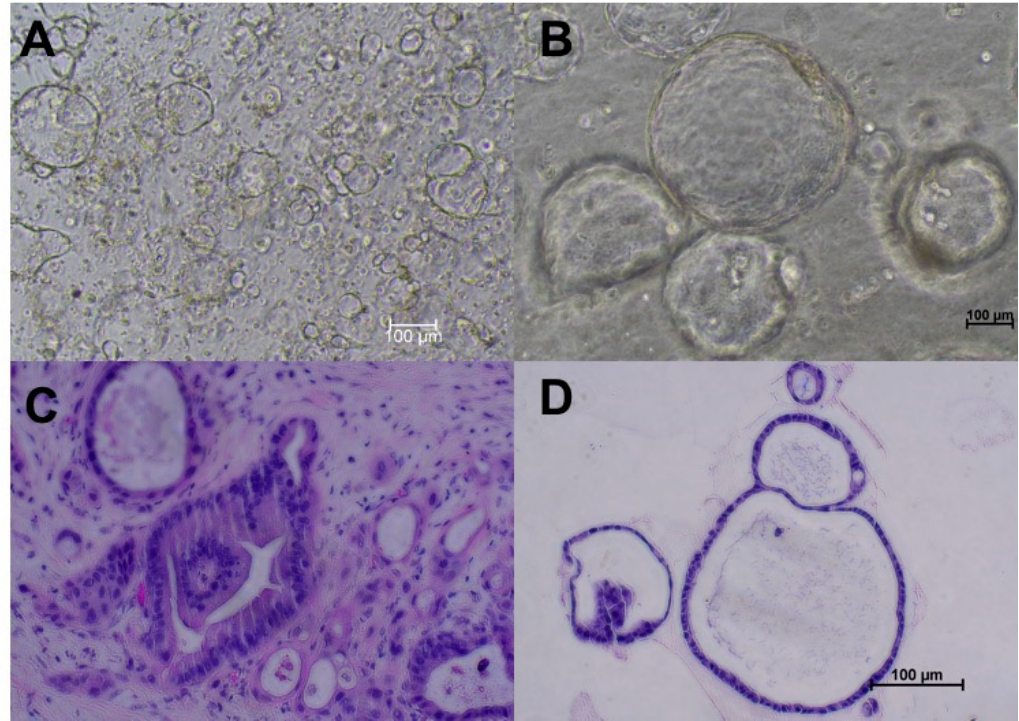
Figure 1. Pancreatic duct adenocarcinoma (PDAC) organoids created from specimens obtained from surgical resection from the same patient. ( A ) Passage 0 (P0) organoids on day 4 after creation. ( B ) P2 PDAC organoids. ( C ) Hematoxylin and eosin stain of tumor tissues from which organoids were derived (200×). ( D ) Hematoxylin and eosin staining of the same organoid line reveals nucleolar prominence and cell adhesions, confirming PDAC origin. All images were taken using the Nikon Ts2 microscope.